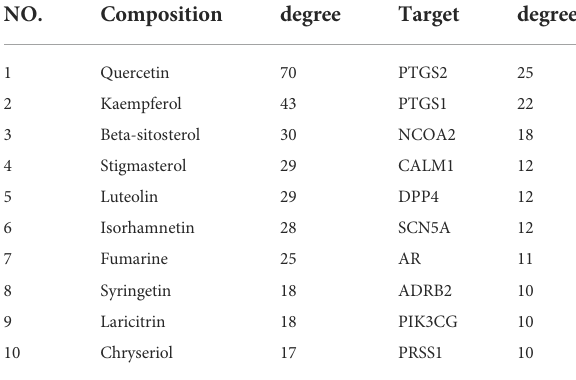
Figure 7A. The protein expression of CAMK4 and p-CREB